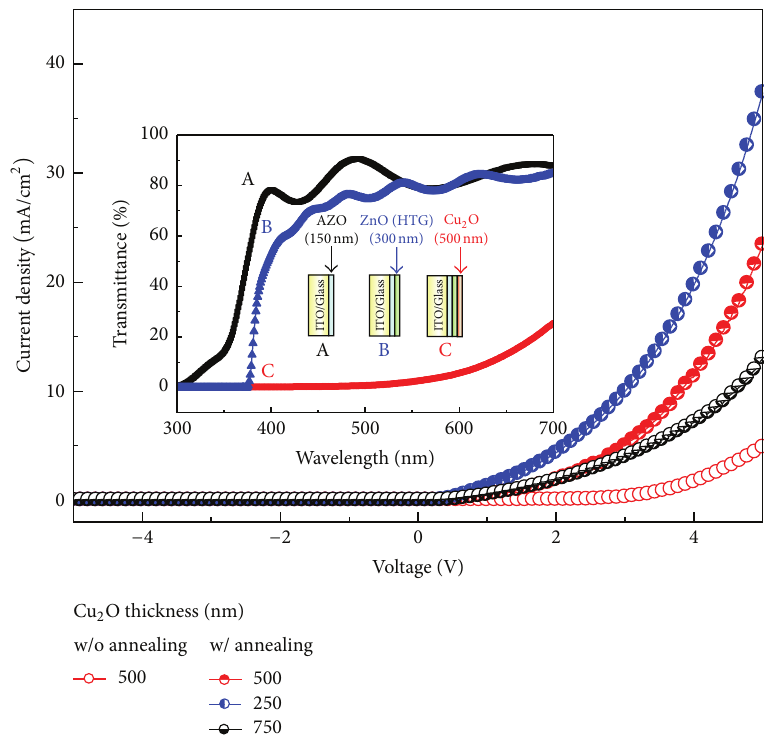
Figure 3: Experimental 𝐽 - 𝑉 curves of p-Cu 2 O/ZnO film (HTG) HJs in darkness. Inset shows the measured transmittance of the prepared samples after annealing. ITO-coated glass substrate after AZO (150nm) layer deposition (structure A), with an additional ZnO film (HTG) (300 nm) (structure B), and with a Cu 2 O layer (500nm) atop structure B (structure C).